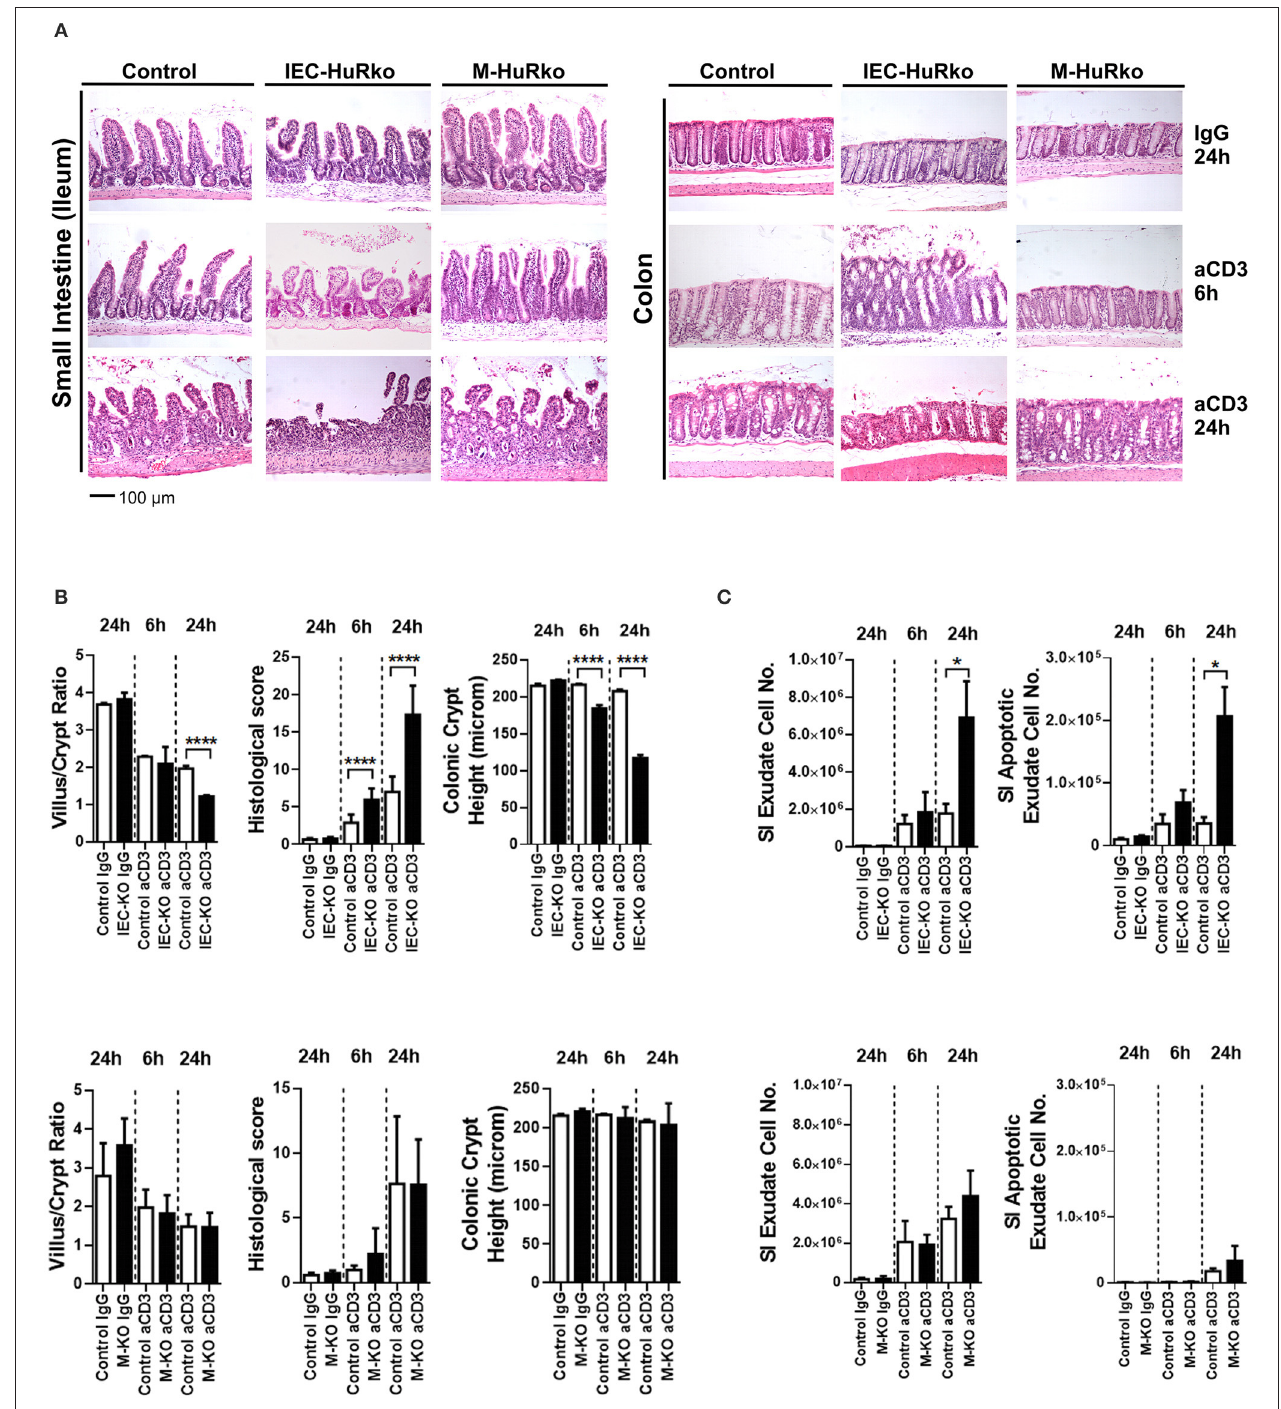
FIGURE 2 | Loss of HuR in IECs –but not in myeloid cells- sensitizes the epithelium to acute inflammatory death signals. (A) Representative H&E histology of paraffin embedded intestines from control and HuR mutant mice exposed either to aCD3 or isotype IgG for the indicated times. (B) Quantification of villus/crypt length ratio, colonic crypt height and histological score of IEC-HuRko treated mice (upper panel) and M-HuRko mice (lower panel). n = 3–6/group/time point. Student unpaired t- test. (C) (left panels) Enumeration of cells expelled in lumen washes from the intestines of mice exposed to aCD3 or IgG control. (right panels) Flow cytometric determination of apoptotic cell numbers of the same exudates, analyzed 6 and 24h post injections in IEC-HuRko (upper panel), M-HuRko (lower panel) mice and respective controls. n = 3–6/genotype/time point. Student unpaired t -test. All bar graphs show means ( ± SE). In all graphs, *,****, denote p -values < 0.05 and 0.0001